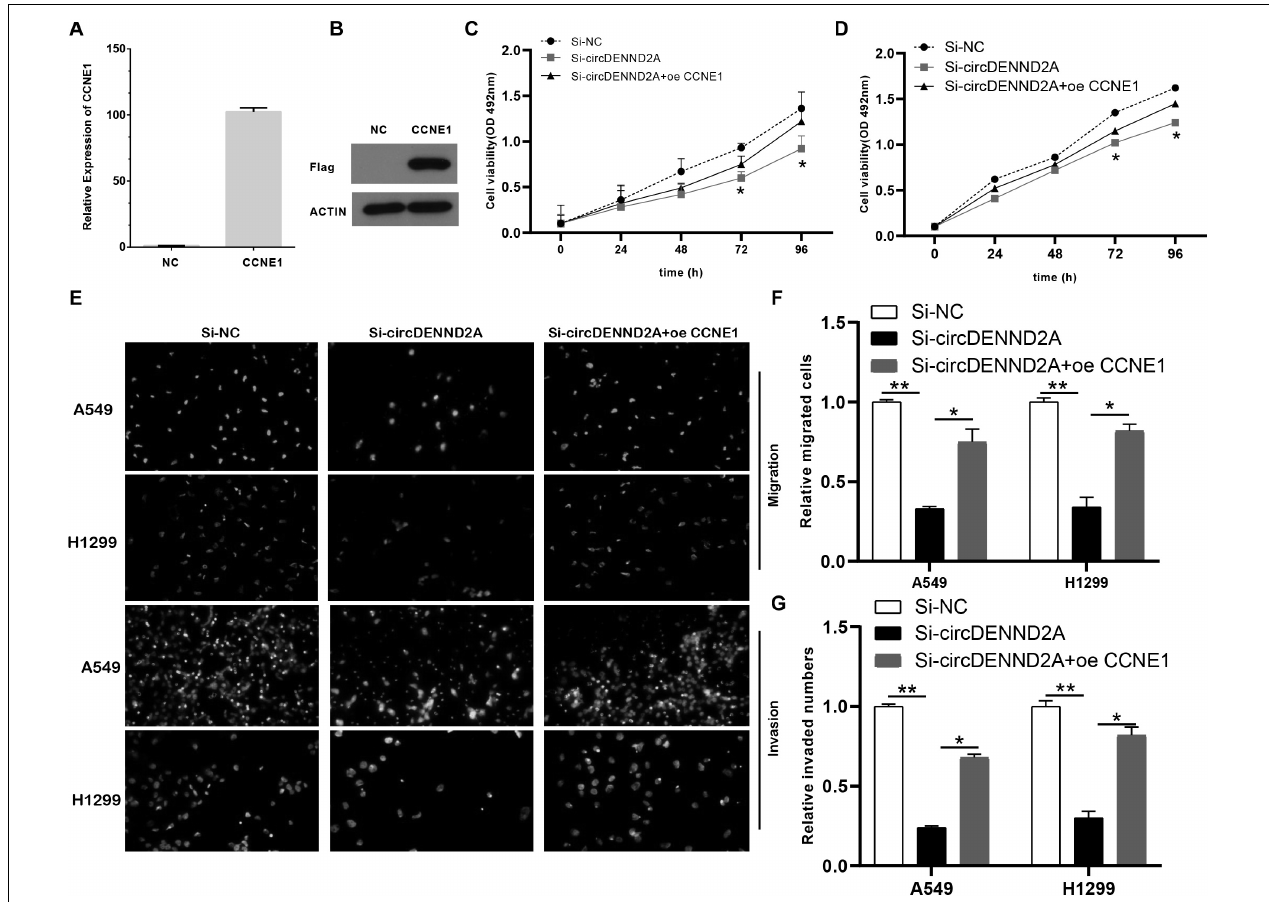
FIGURE 6 | Restoration of CCNE1 impaired the inhibitory effects of circDENND2A silencing. (A,B) The mRNA (A) and protein (B) expression of CCNE1 was determined in A549 cells of circDENND2A knockdown. (C,D) CCK-8 assays demonstrated that CCNE1 overexpression could largely reverse the suppressive effects of circDENND2A silencing on proliferation of A549 and H1299 cells. (E–G) CCNE1 overexpression partly reversed the suppressive effects of circDENND2A silencing on migration and invasion of A549 and H1299 cells (* P < 0.05, ** P < 0.01). CCK-8, Cell Counting